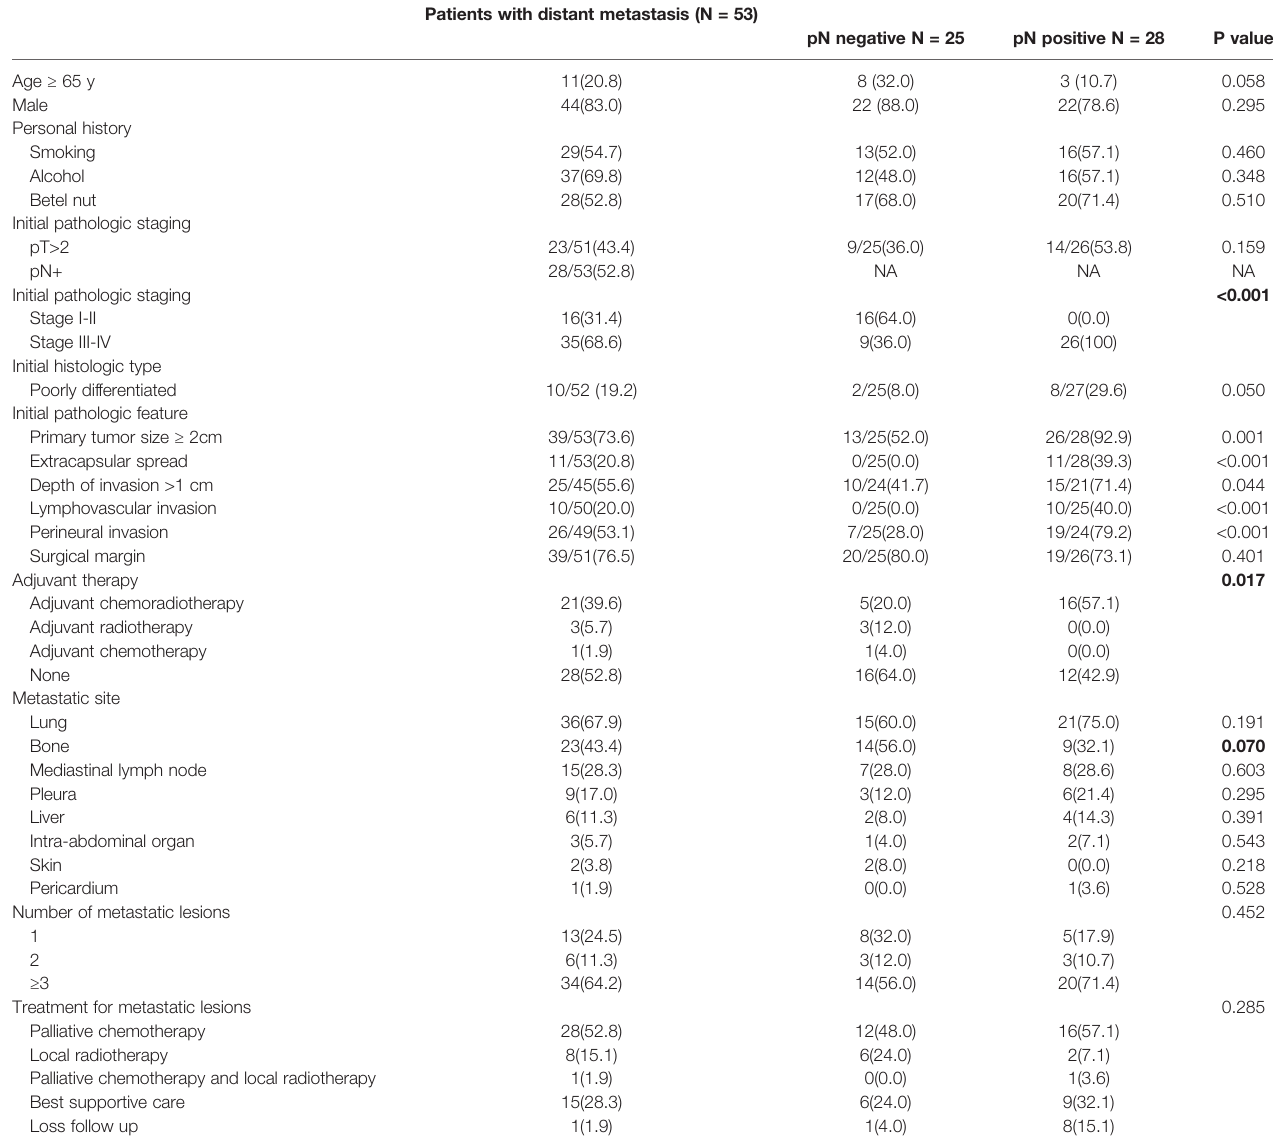
TABLE 2 | The presentations of metastatic lesions.